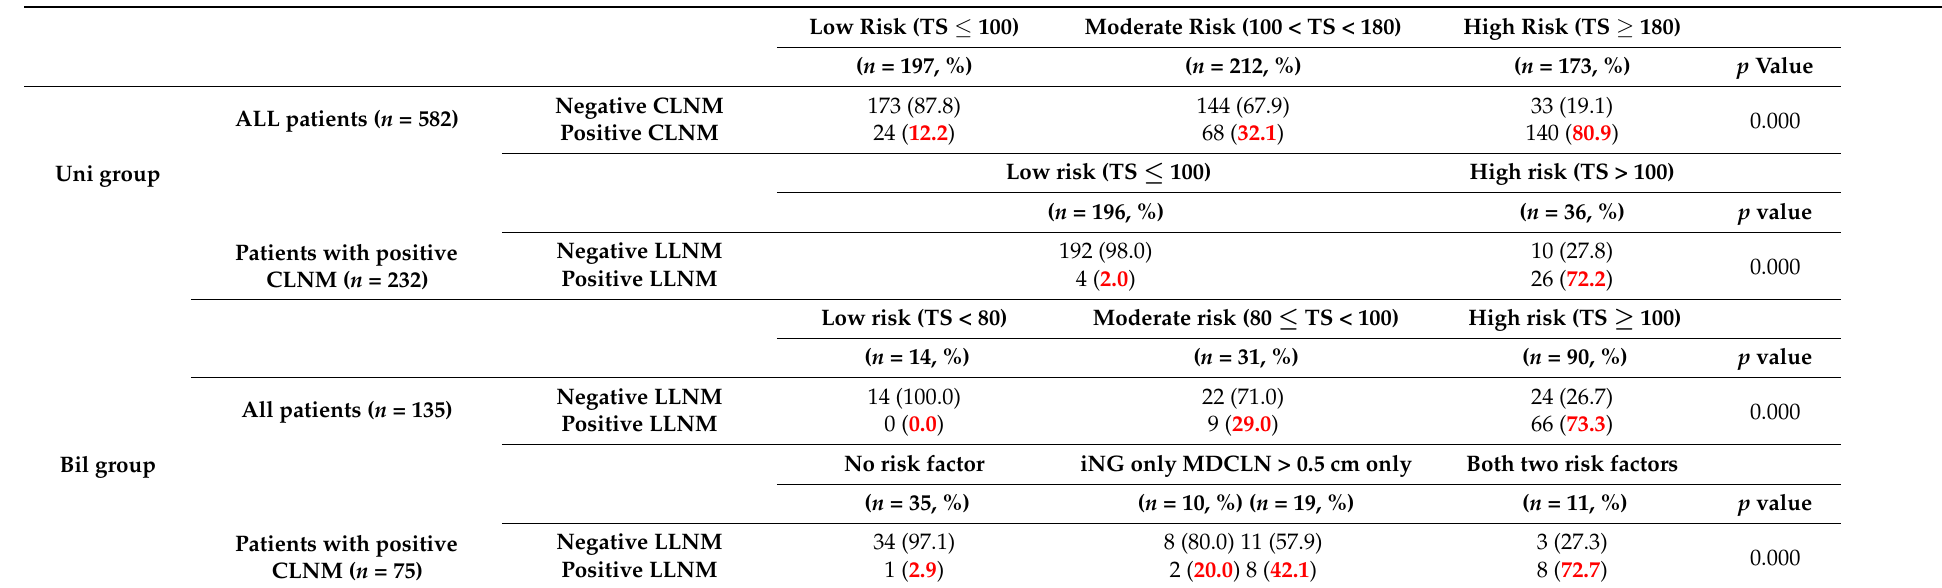
Table 5. Risk stratification of CLNM and LLNM for PTMC patients within Uni and Bil